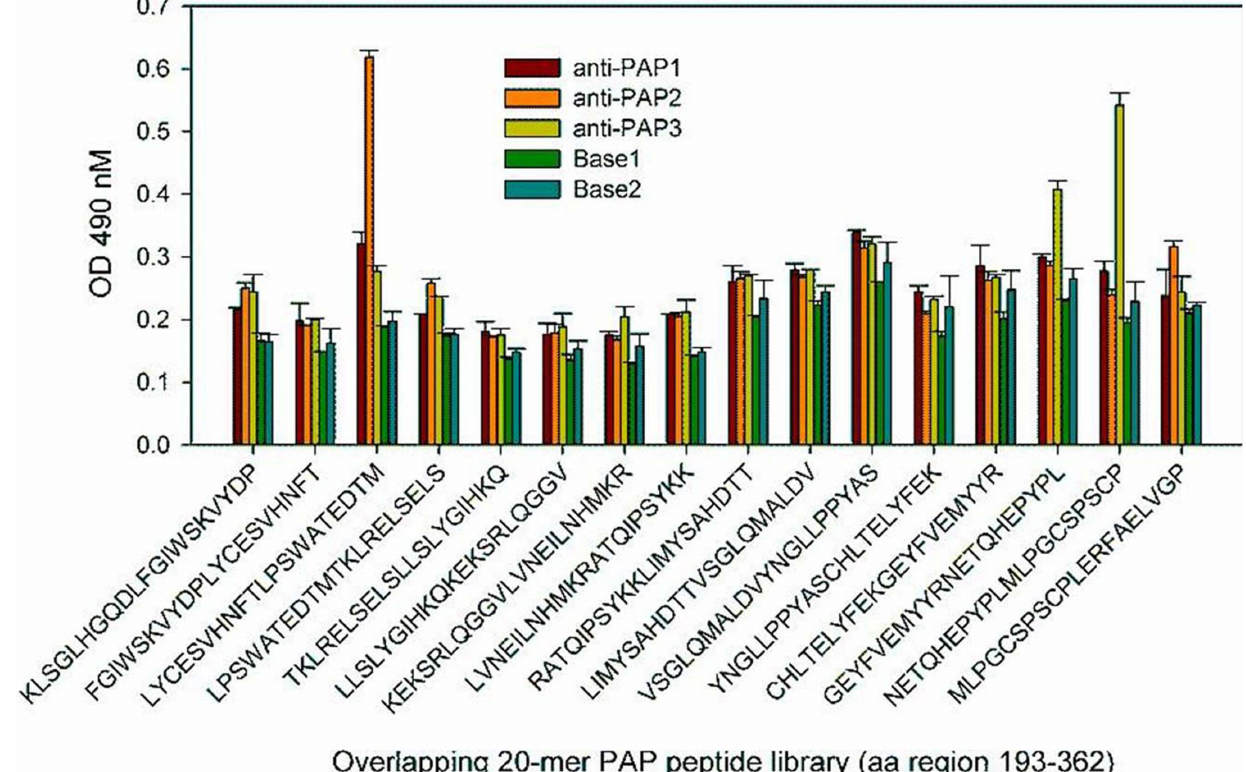
Figure 4. Epitope mapping for human PAP-specific antibodies from four immune sera samples . The reactivity of 4 mouse PAP-specific immune sera (PAP1, PAP2, PAP3 and PAP4) was tested by ELISA using a library of overlapping 20-mer peptides that span the entire amino acid sequence of human PAP. Base1 and base 2 samples derived from naı¨ve mice served as negative controls. The results for the PAP protein region corresponding to amino acids 193–362 are shown.